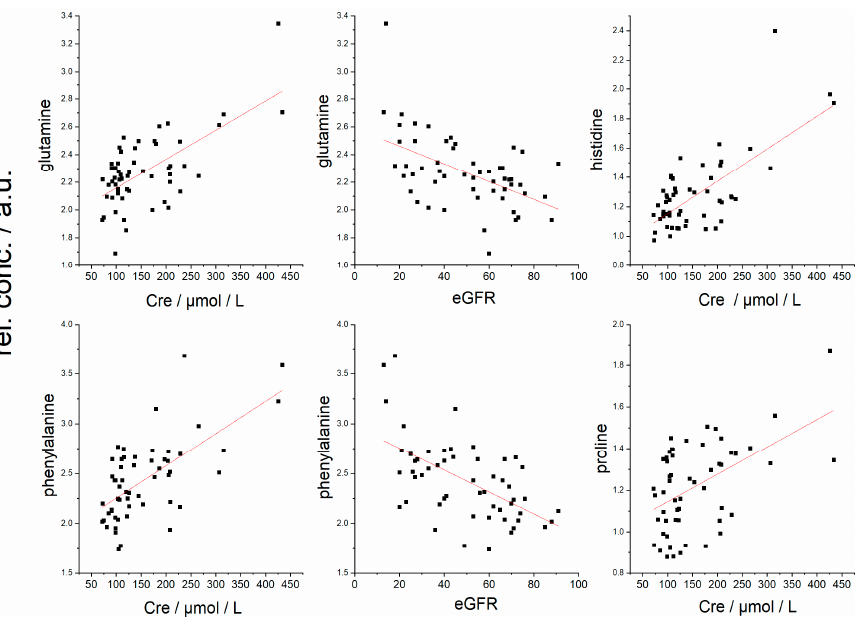
Figure 4. Plasma levels of glutamine, phenylalanine, histidine, and proline in relation to eGFR, and plasma levels of histidine and proline in the relation to serum creatinine—Cre.